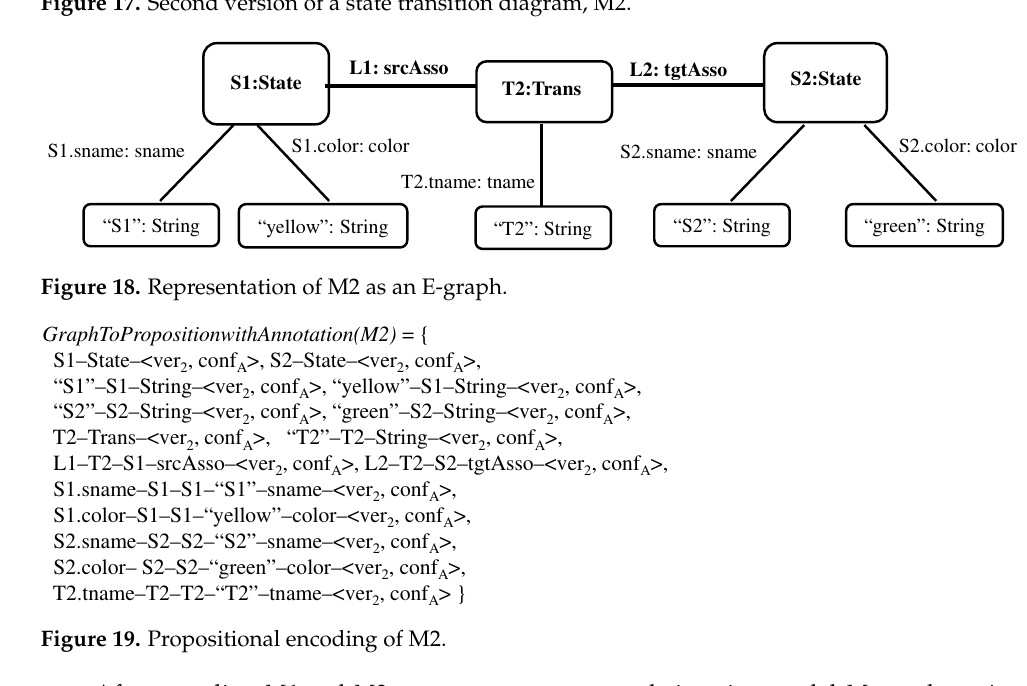
Figure 17. Second version of a state transition diagram, M2.